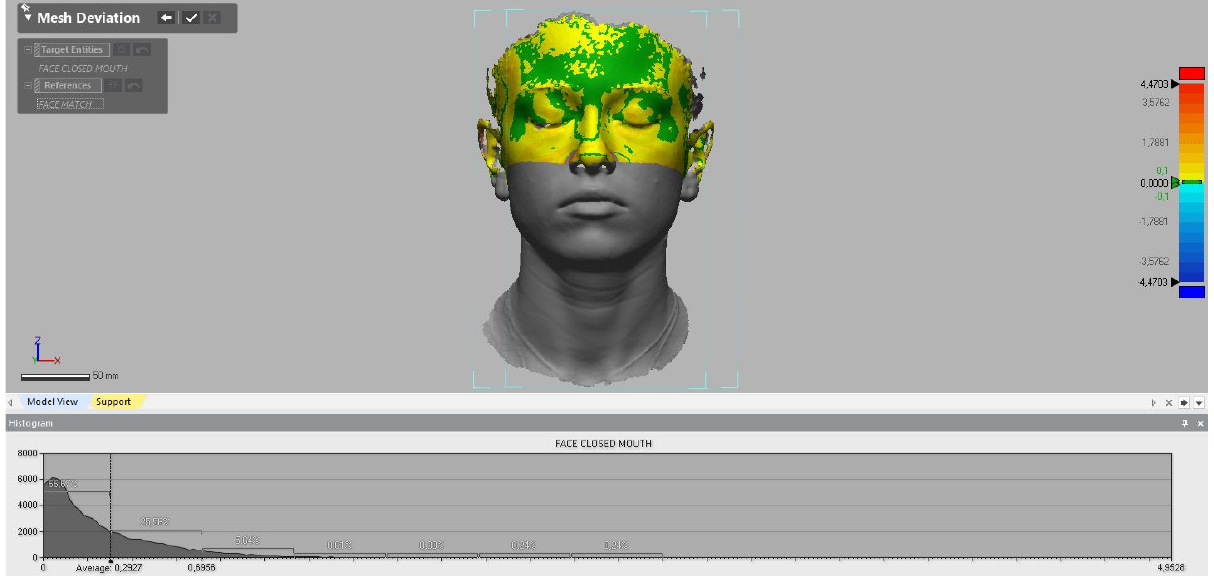
Figure 13. 3D deviation analysis between face scan with lip-and-cheek retractor and face scan with the mouth closed. RGB-colored scale bar (millimeters) is reported on the right. Histogram chart is reported at the bottom.